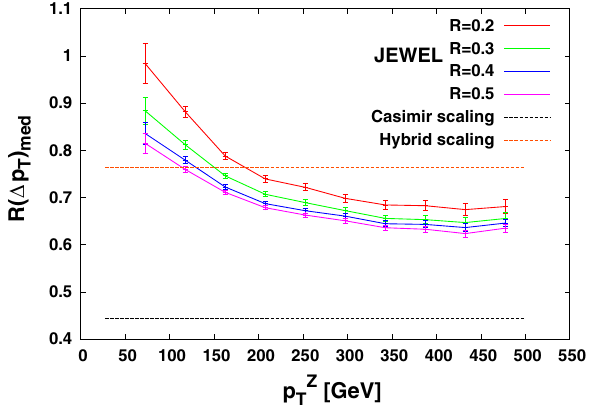
Fig. 4 R (Δ p T ) med as a function of the reconstructed jet radius